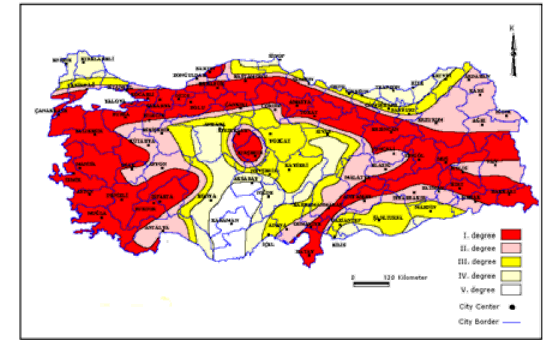
Figure 2. Earthquake Zones of Turkey Source: URL2, 2013 1st degree earthquake zone : more than 0.4 g 2nd degree earthquake zone : between 0.3 – 0.4